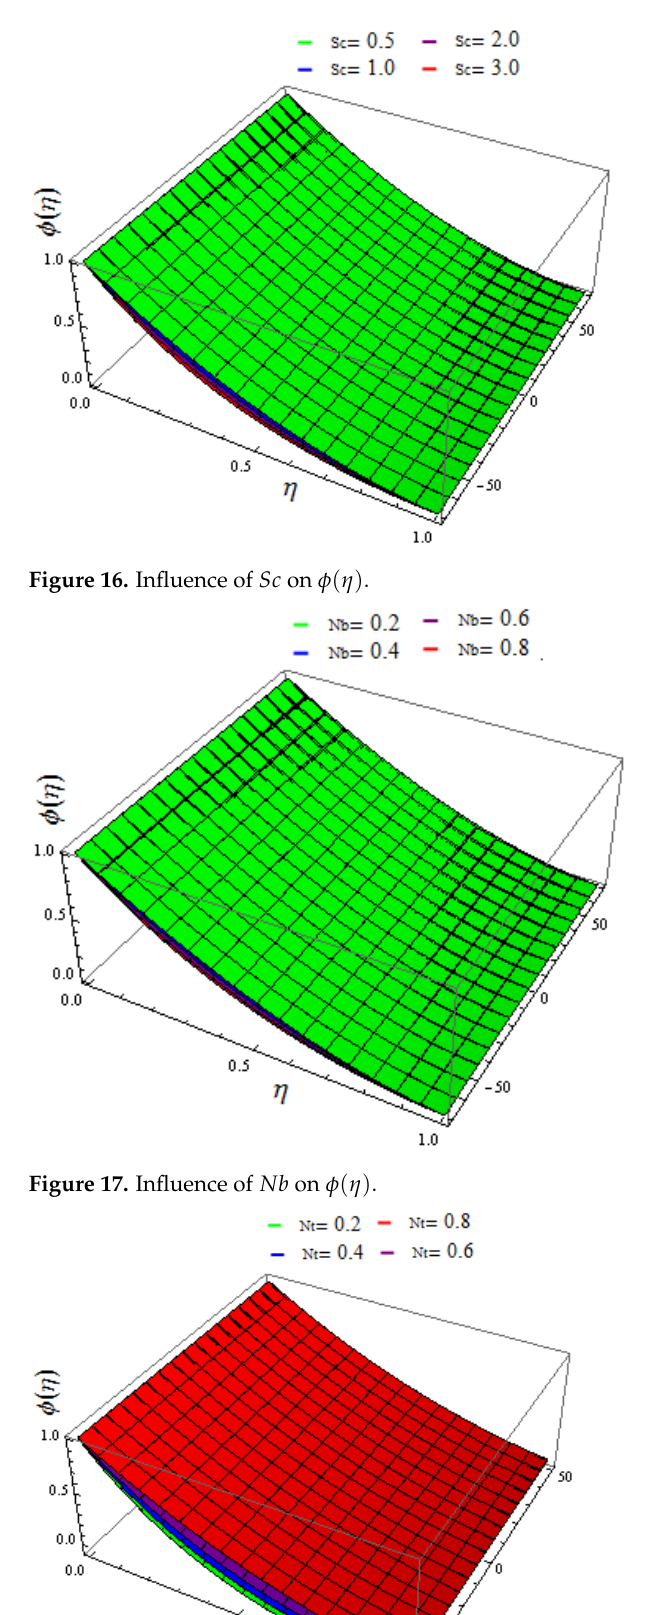
Figure 19. Influence of 𝛿 on 𝜙(𝜂) .